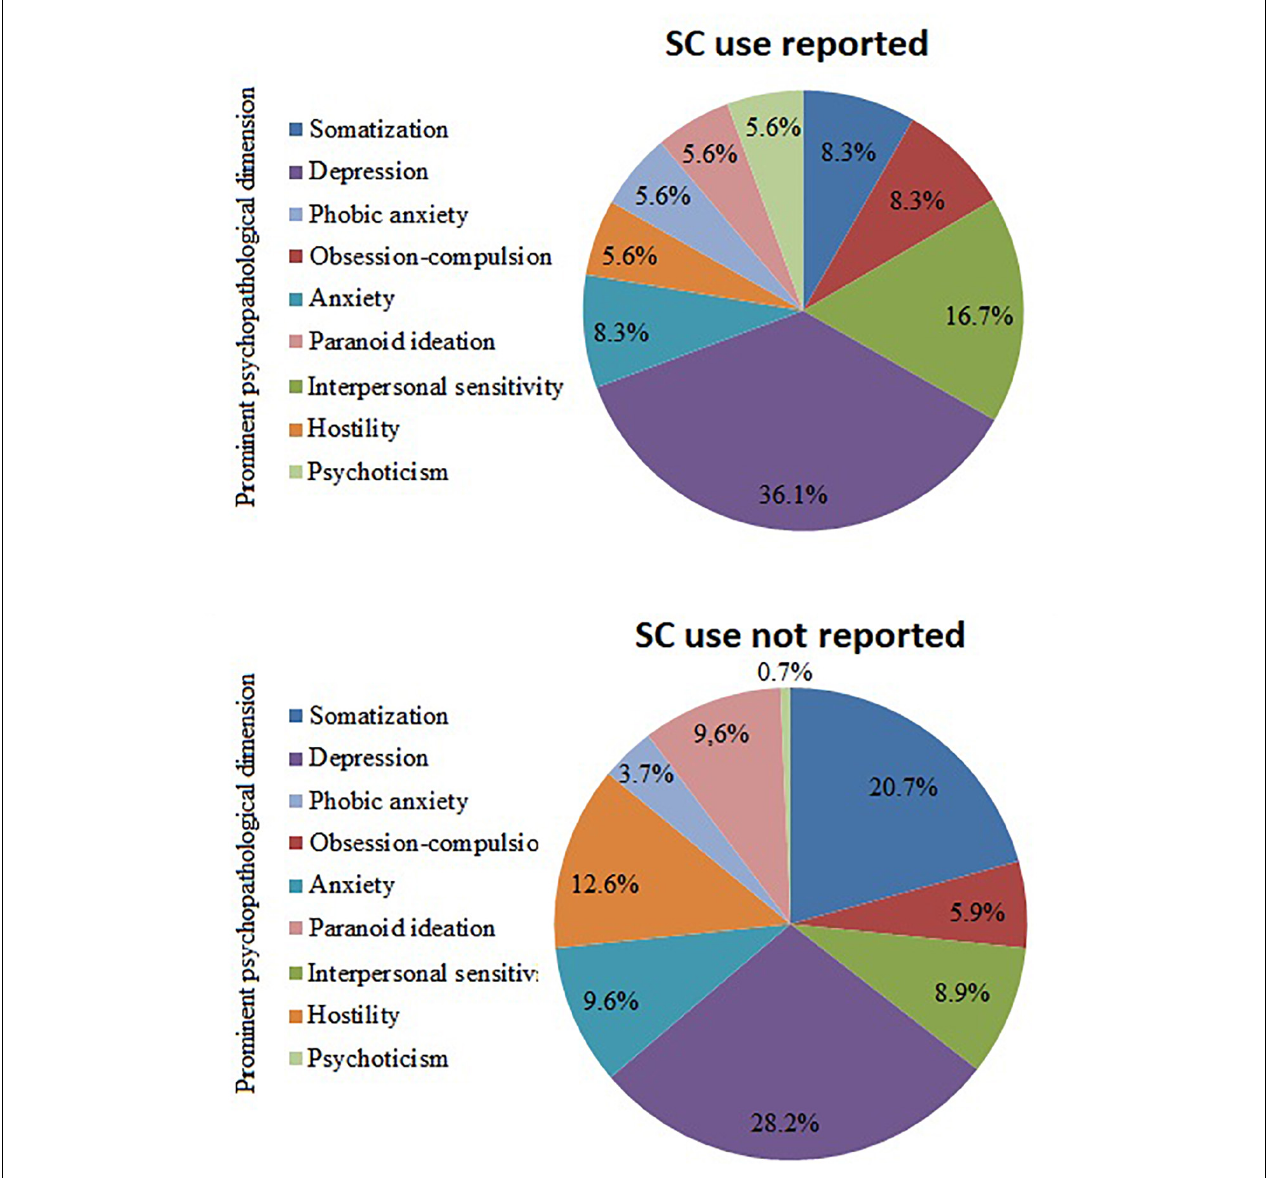
FIGURE 3 | Distribution of prominent psychopathological dimensions with and without reported SC use. SC, synthetic